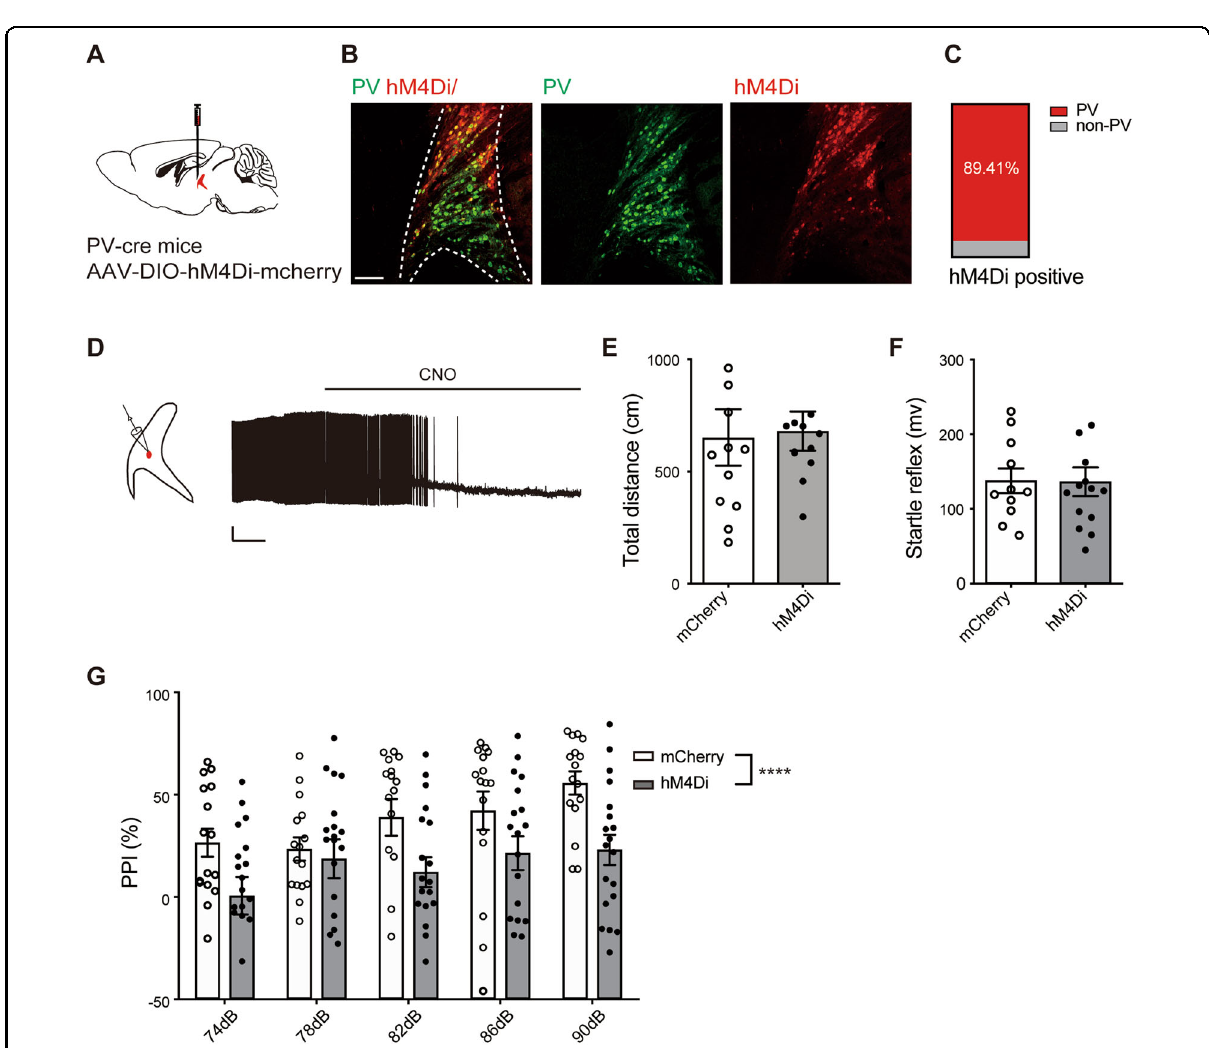
Fig. 3 Chemogenetic inhibition of PV + neurons in audTRN impairs PPI performance. A Strategy of chemogenetic inhibition of PV + neurons in audTRN. A Cre-dependent AAV for expression of hM4Di was bilaterally injected into the audTRN in PV-cre mice. B Left, example of confocal image showing overlap of hM4Di + neurons (red, right) and PV + neurons (green, middle). White dotted lines mark the border of the audTRN. Scale bar: 100 µm. C Quanti fi cation shows that approximately 89.41% of hM4Di cells are PV + ( N = 9 slices of 3 mice). D Left, schematic of experiment design. Right, a representative trace recorded in current-clamp mode from an audTRN PV neuron that expressed hMD4i. Scale bars: 1 min, 20 mV. Application of CNO (5 µM) abolished neuronal fi ring. E , F Application of CNO (3 mg/kg, i.p.) to mice that expressed hMD4i in audTRN PV neurons had no effect on total distance in OFT (Student ’ s t -test, t 22 = 0.1871, P = 0.8533, N = 12 mice per group) or startle re fl ex in PPI (Student ’ s t -test, t 23 = 0.0559, P = 0.9559, N mCherry = 11 mice, N hM4Di = 14 mice). G Application of CNO (3 mg/kg) to mice that expressed hMD4i in audTRN PV neurons impaired PPI performance (two-way ANOVA, F (1,165) = 18.90, P < 0.0001, N mCherry = 16 mice, N hM4Di = 19 mice). **** P <